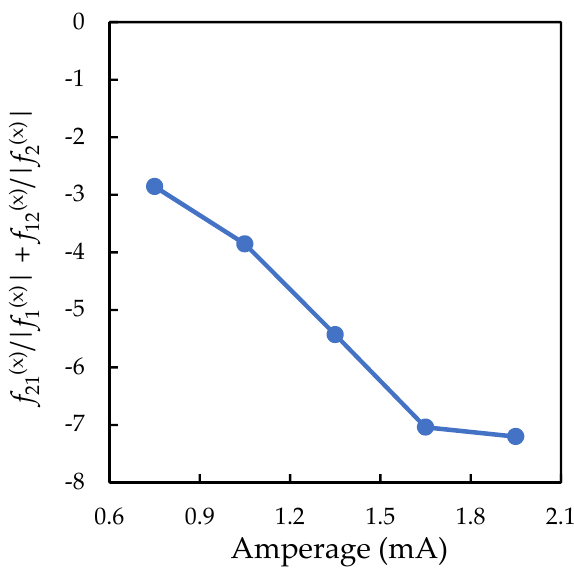
Figure 6. Left part of the inequality (1), depending on the discharge current.